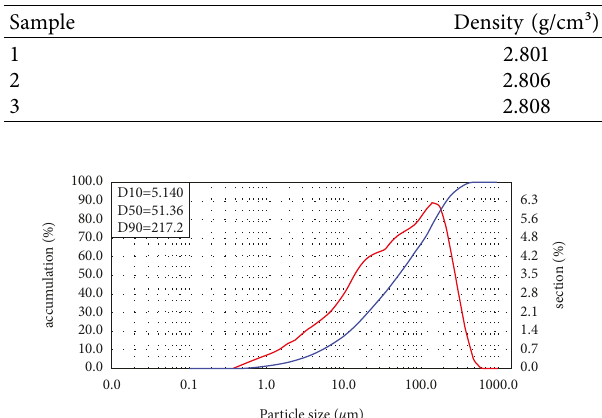
Figure 1: Differential and cumulative distribution curves of whole tail sand particle